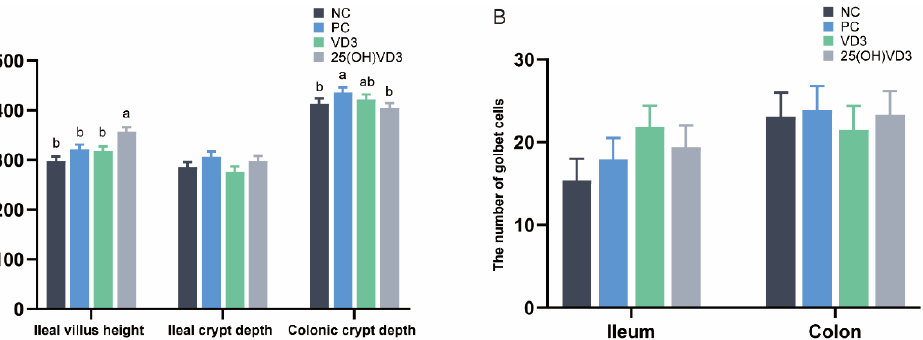
Figure 2. Effect of VD 3 and 25(OH)VD 3 on the intestinal morphology of weaned piglets. ( A ): The length of villus height and crypt depth in the piglets. ( B ): The numbers of goblet cells in the ileum and colon. Note: Different letters on the top of the column indicate significant differences ( p < 0.05), n = 6. NC, negative control; PC, positive control; VD 3 , vitamin D 3 ; 25(OH)VD 3 , 25-hydroxyvitamin D 3 .